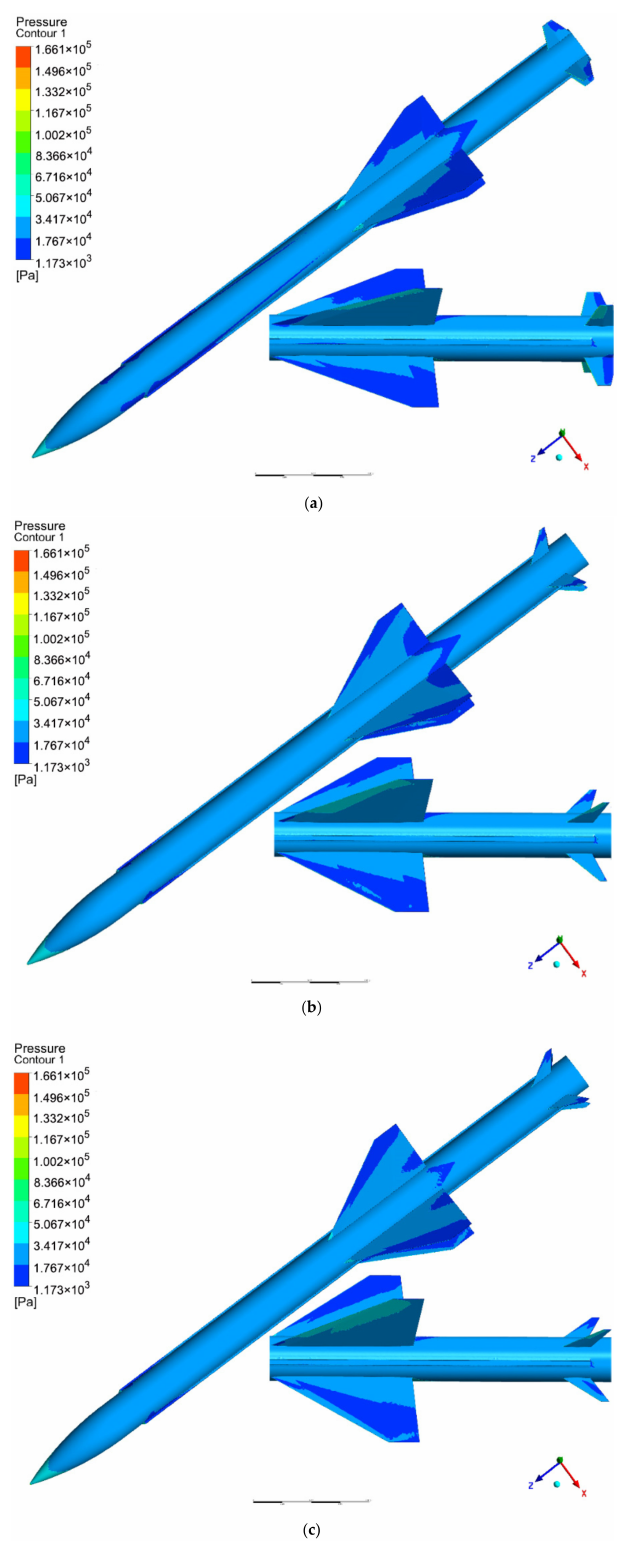
Figure 17. Comparison between flowfield cloud images and the three schemes considered herein. ( a ) Initial configuration design ( α = 10 ◦ ), ( b ) deterministic optimization ( α = 8 ◦ ), ( c ) and uncertainty- based optimization ( α = 8 ◦